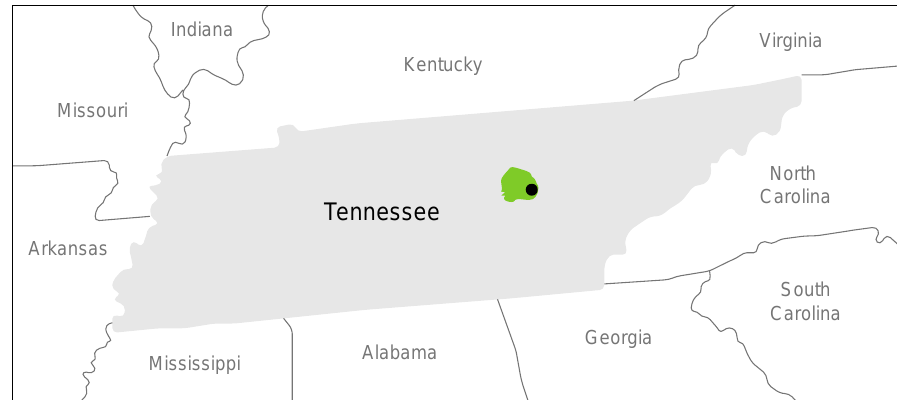
Figure 2. Map showing the location of the Bridgestone–Firestone Centennial Wilderness (black dot) in White County (green), TN, USA.